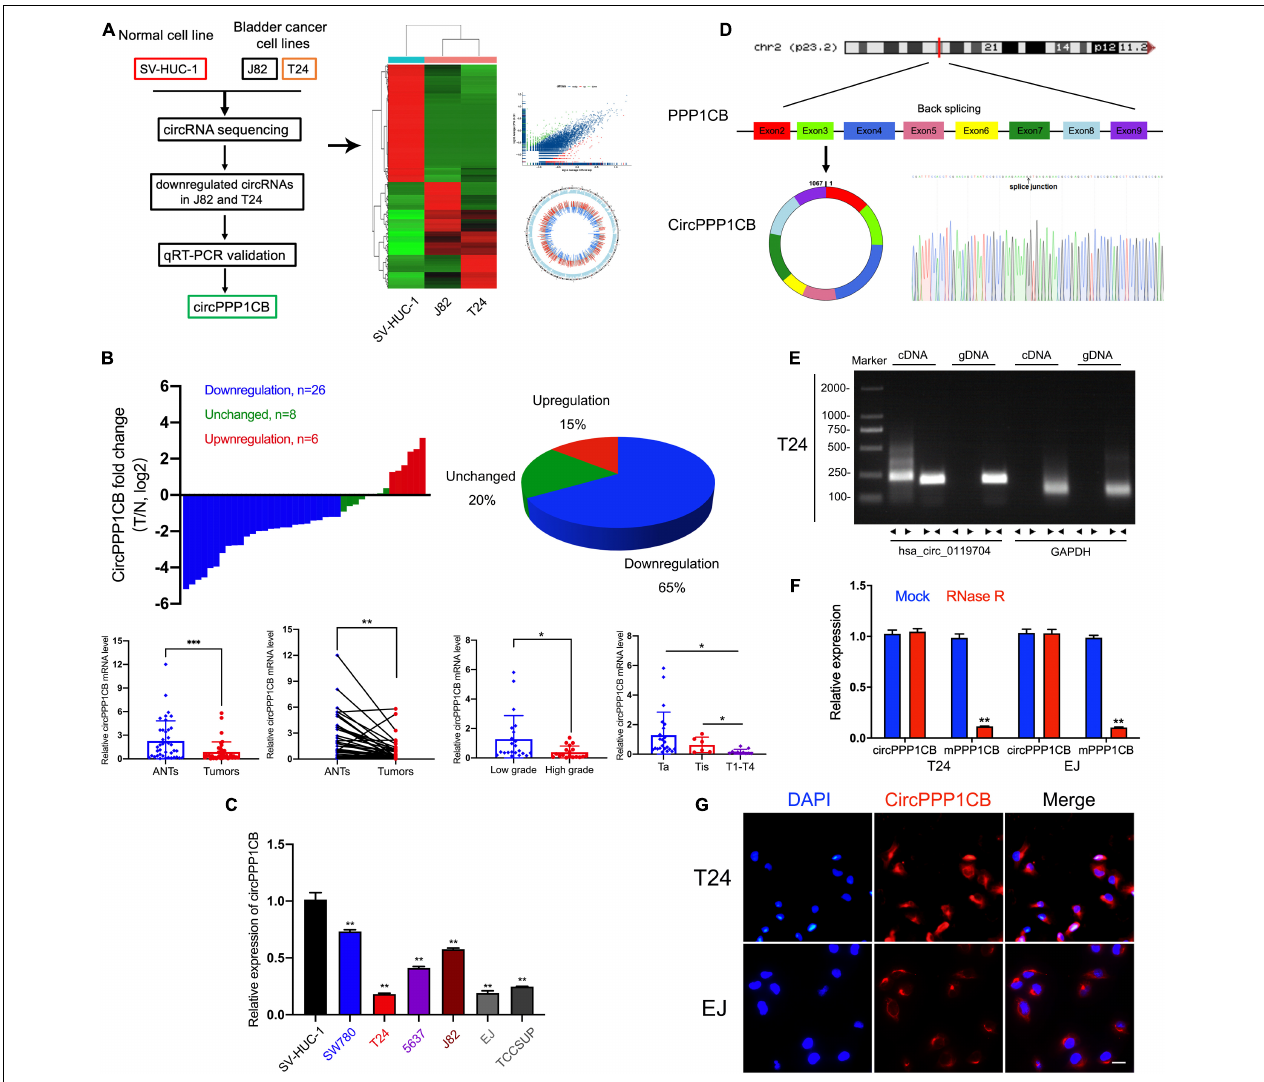
FIGURE 1 | CircRNA sequencing and validation of circPPP1CB in bladder cancer tissues and cells. (A) CircRNA sequencing was performed in SV-HUC-1, J82, and T24 cell lines. A flow diagram, a heat map, and a volcano plot were presented. (B) CircPPP1CB levels were detected in surgical specimens collected from bladder cancer patients ( n = 40). CircPPP1CB was downregulated in bladder cancer and was correlated with clinical stages and histological grades. (C) . Detection of circPPP1CB fold change in SV-HUC-1, SW780, T24, 5637, J82, EJ, and TCCSUP was performed by qRT-PCR. (D) CircPPP1CB was formed via circularization of exons 2, 3, 4, 5, 6, 7, 8, and 9 of PPP1CB. The head-to-tail splicing junction was also validated and indicated by Sanger sequencing. (E) CircPPP1CB could be amplified efficiently by divergent primers in cDNA in T24 cells. GAPDH was used as a negative control. (F) To verify the tolerance to RNase R, expression levels of circular and linear PPP1BC mRNAs were determined by qRT-PCR. (G) CircPPP1CB was predominantly located in the cytoplasm of bladder cancer cells. CircPPP1CB was stained by a specific probe (red), while nuclei were stained with DAPI (blue). Scale bars, 100 µ m. Data are presented as mean ± SD of